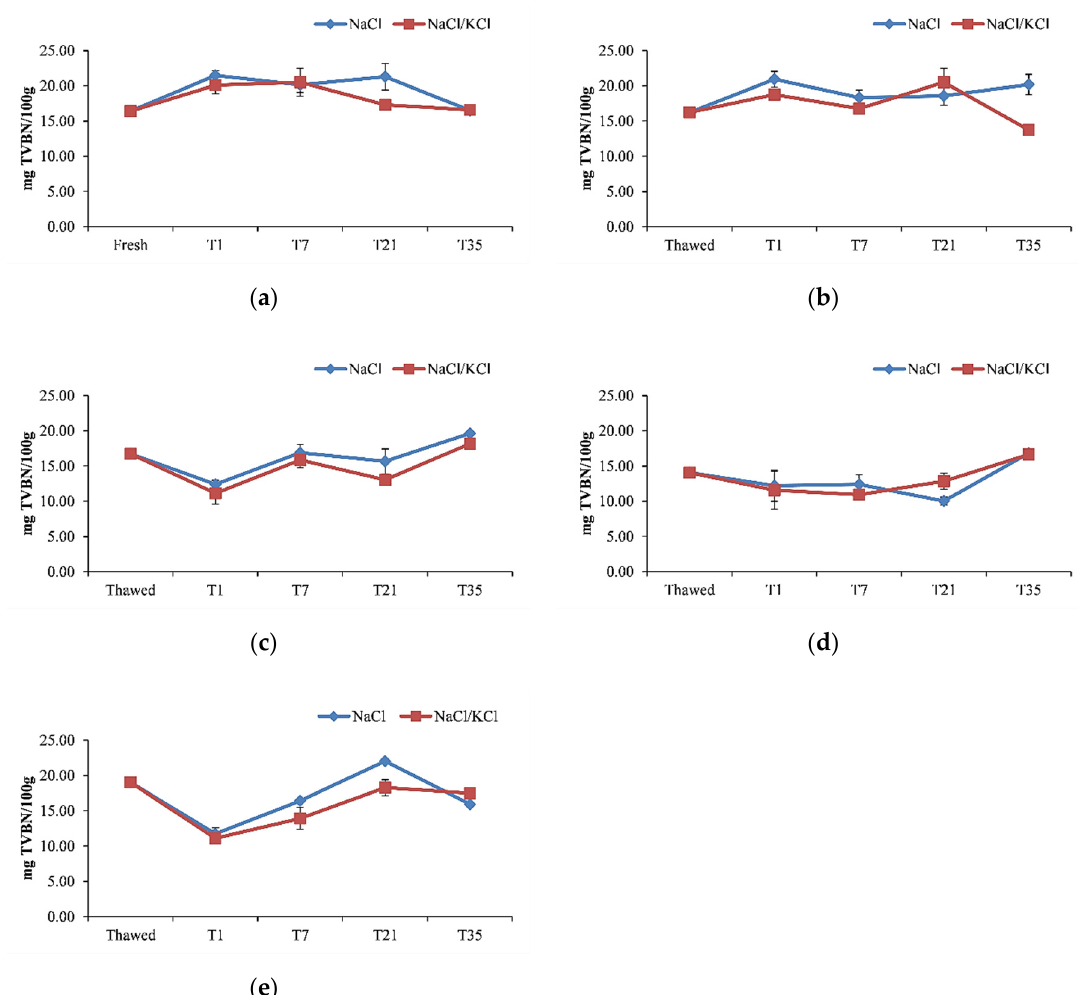
Figure 4. Total volatile basic nitrogen (TVBN) (mg/100 g) in the smoked fillets of D. labrax during the 35 days of preservation, in the five smoking processes. ( a ) smoking I; ( b ) smoking II; ( c ) smoking III; ( d ) smoking IV; ( e ) smoking V.